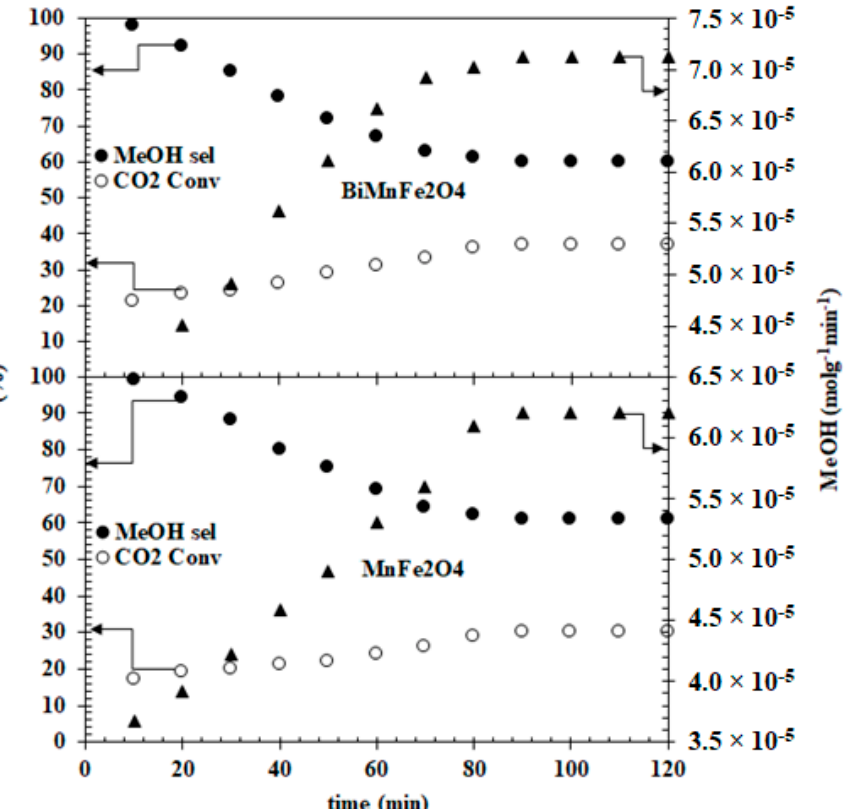
Figure 3. Time profile study of CO 2 conversion to MeOH by MnFe 2 O 4 and Bi-MnFe 2 O 4 catalysts. Reaction conditions: pressure: 1 bar, temp: 493 K, GHSV: 22,000 h − 1 , feed ratio 3/1: H 2 /CO 2.